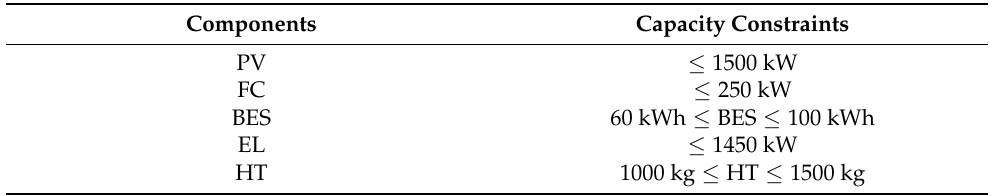
Table 3. Capacity limits of optimization variables applied when minimizing the objective function in Equation